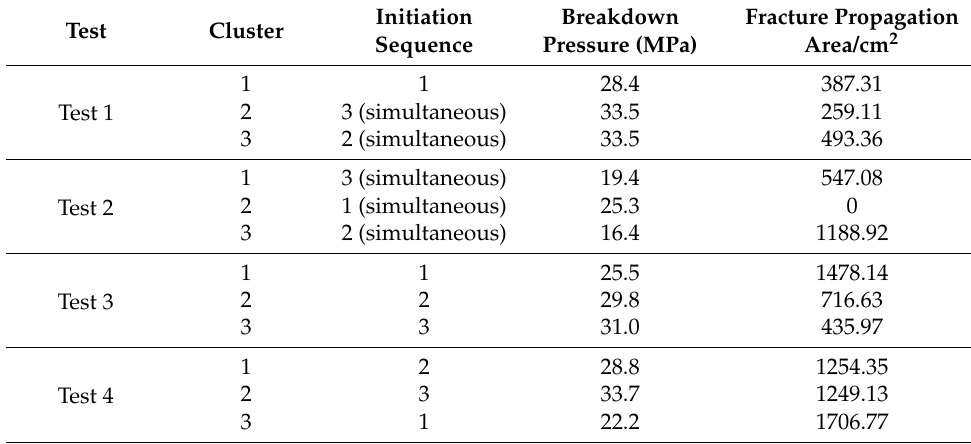
Figure 8. Hydraulic fracture morphology of each cluster for all specimens: ( a ) Test 1; ( b ) Test 2; ( c ) Test 3; ( d ) Test 4; ( e ) Test 5; ( f ) Test 6. Table 3. Experimental results of each test.